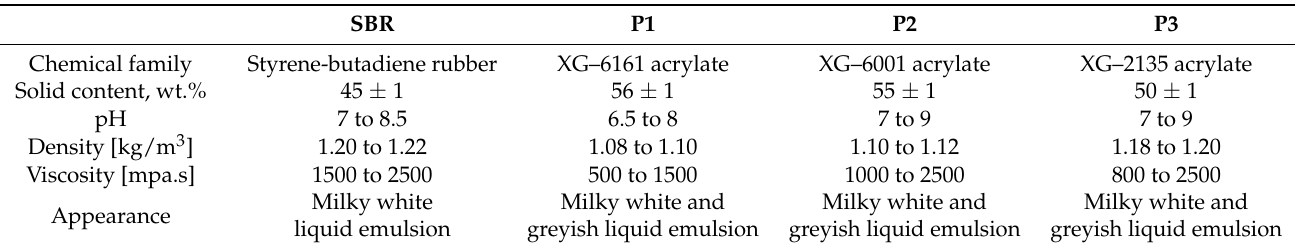
Table 2. Polymer latex characteristics.